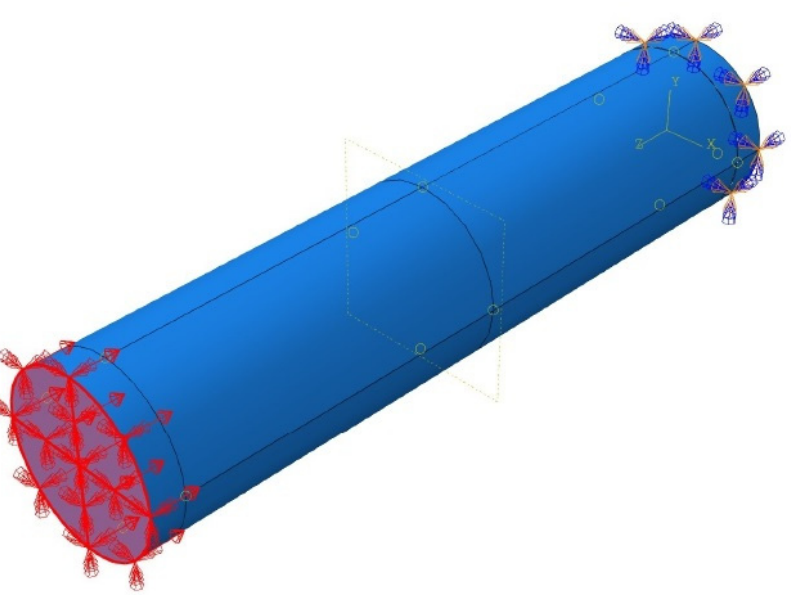
Figure 8. Proposed boundary conditions for GFRP-RC HCCs tested in the current paper.